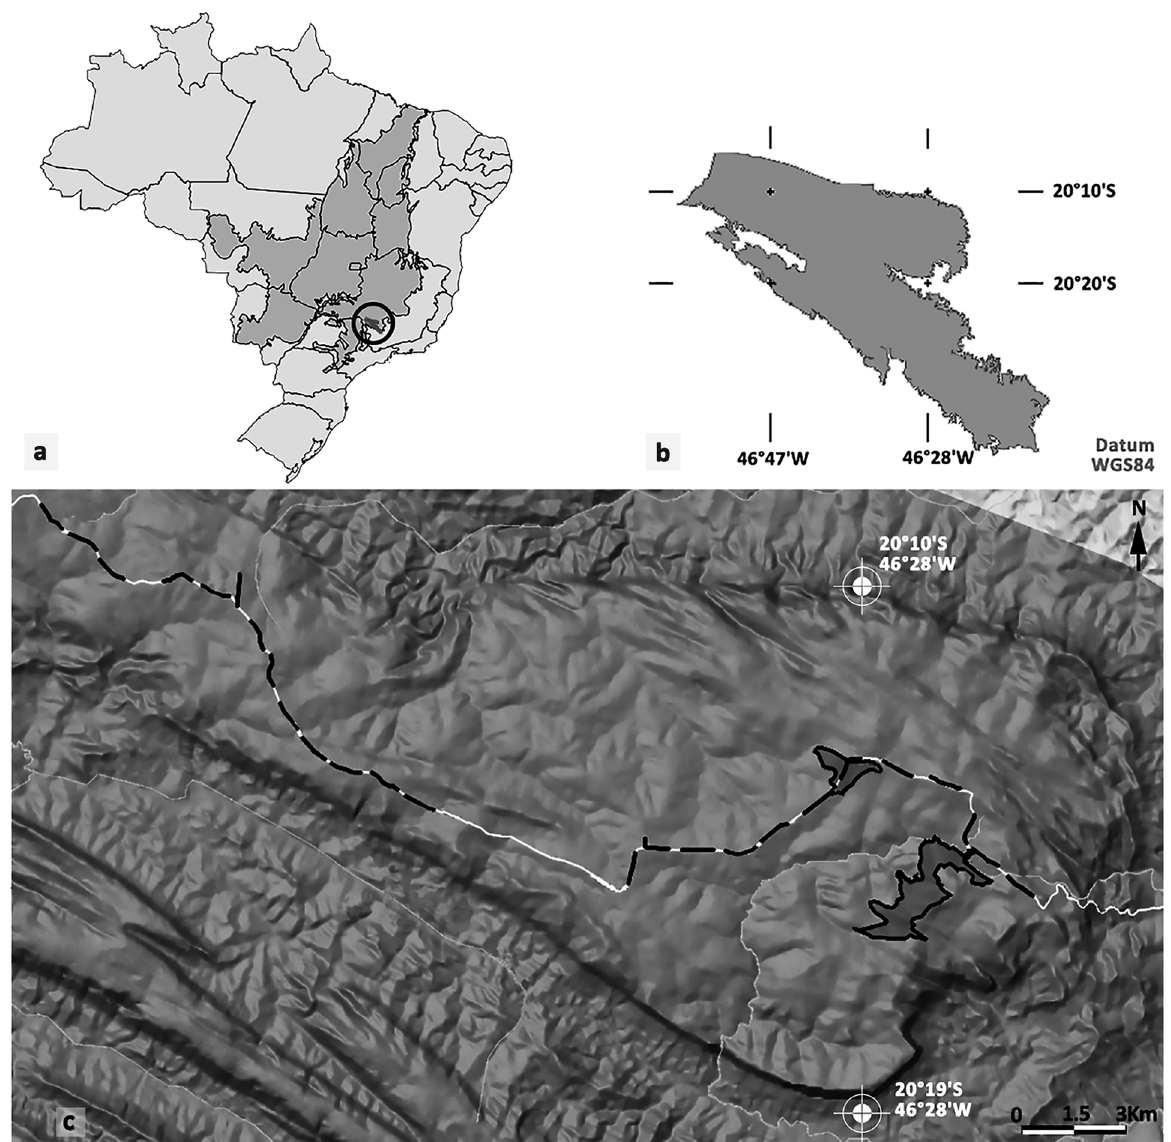
Figure 1 - Location of the study area. (a) Political map of Brazil, with the Cerrado biome highlighted. The circle in southern Cerrado indicates the location of the Serra da Canastra National Park (SCNP). (b) Area of SCNP (200,000 ha) with geographical coordinates. (c) Map of the sampling sites. The black lines are 25 transects of 1 Km length where prescribed burnings were annually set. The two areas of irregular shape indicate the limits of natural fi res that occurred in December 2012 (the largest) and September